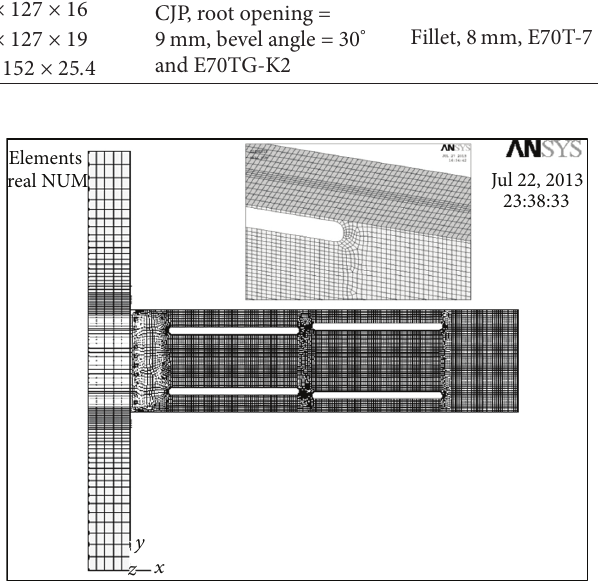
Figure 4: Typical finite element mesh of a RBW with multilongitu- dinal